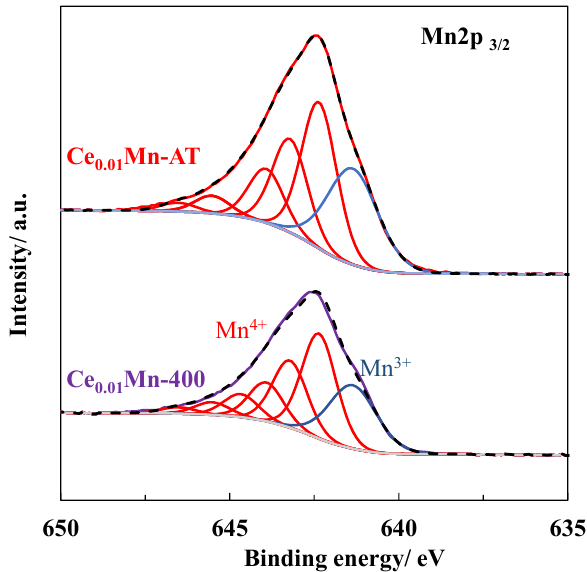
Figure 4. XPS Mn2p 3/2 core level decomposition for Ce 0.01 Mn-400 and Ce 0.01 Mn-AT samples.